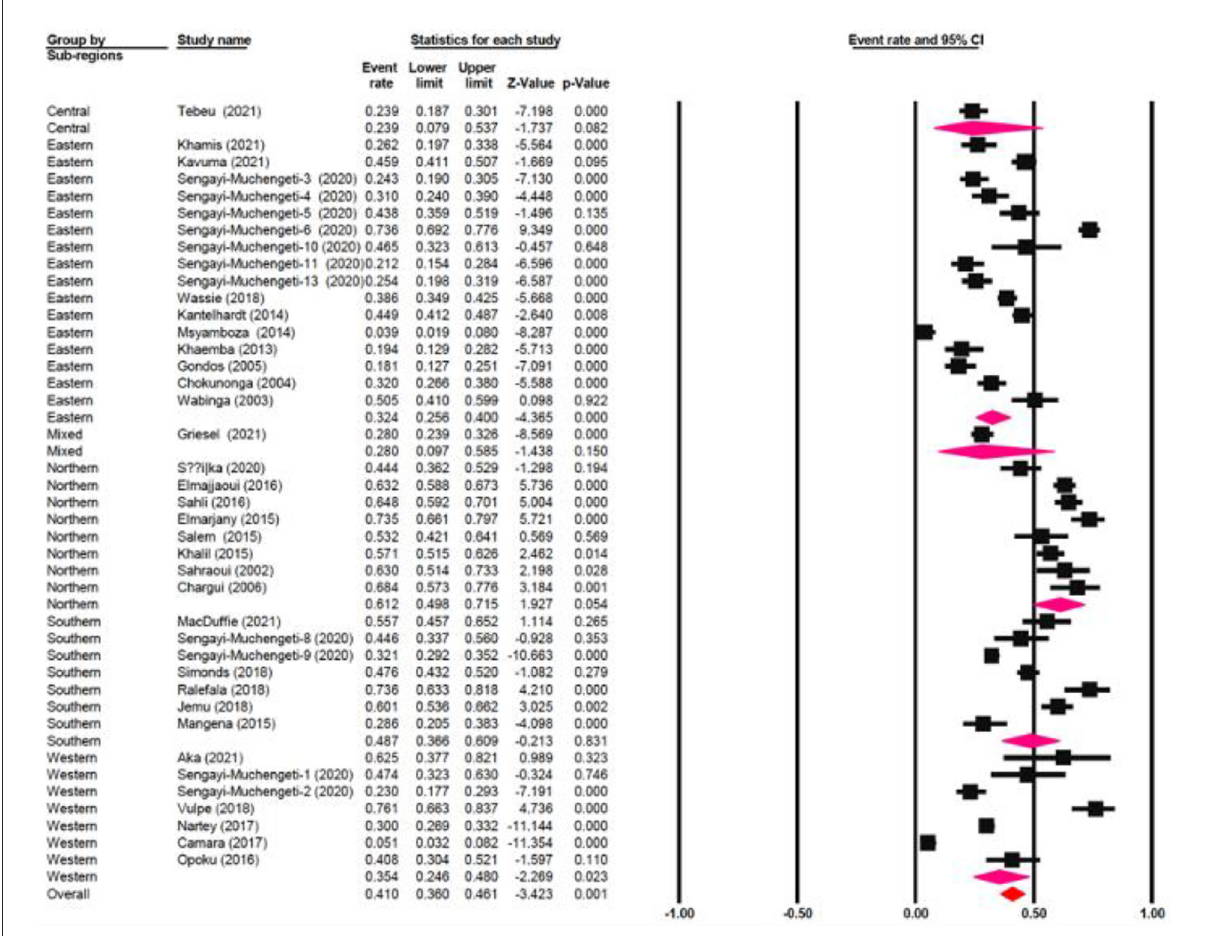
FIGURE6 Forest plot of regional